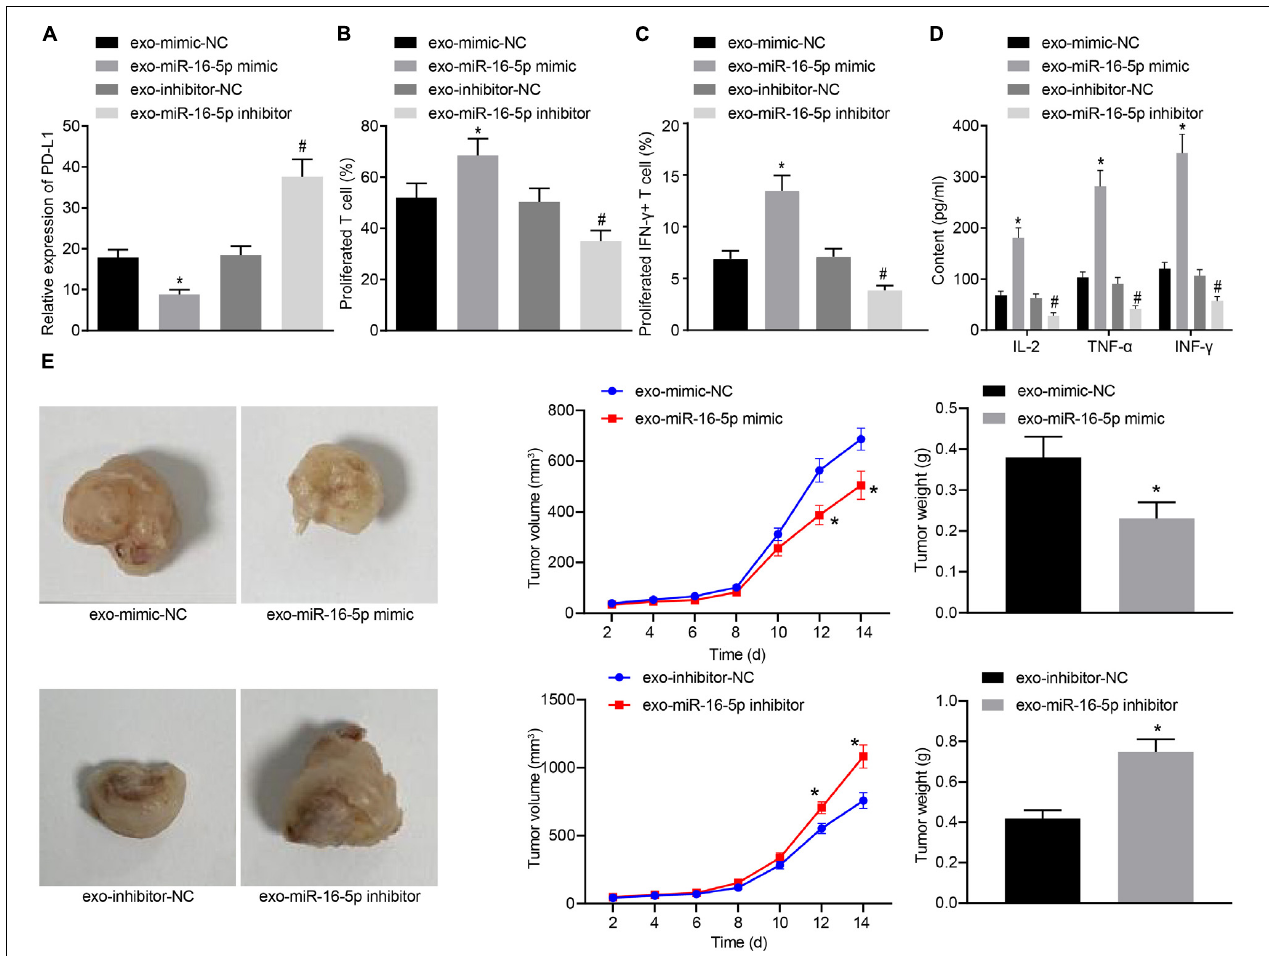
FIGURE 5 | Exosomes secreted from M1 macrophages harboring miR-16-5p promote the activation of T cells in the co-culture system with GC cells. (A) Flow cytometry of PD-L1 expression in GC cells treated with exo-miR-16-5p mimic and exo-miR-16-5p inhibitor. (B) Flow cytometry of CD3 + T cell proliferation in GC cells co-cultured with T cells for 24 h after treated with exo-miR-16-5p mimic or exo-miR-16-5p inhibitor. (C) Flow cytometry of the number of INF- γ + T cells in GC cells co-cultured with T cells for 24 h after treated with exo-miR-16-5p inhibitor or exo-miR-16-5p inhibitor. (D) ELISA was performed to determine levels of IL-2, TNF- α and INF- γ in the supernatant of T cells after treated with exosomes. (E) Representative images of tumors in mice after tail injection of GC cells stably transfected with exo-miR-16-5p mimic or exo-miR-16-5p inhibitor as well as quantification of tumor volume and weight ( n = 5). * p < 0.05 cells treated with exo-mimic-NC; # p < 0.05 compared with cells treated with exo-inhibitor-NC. Measurement data representative of three independently conducted experiments expressed as the mean ± standard deviation. Comparisons between two groups are analyzed by non-paired t